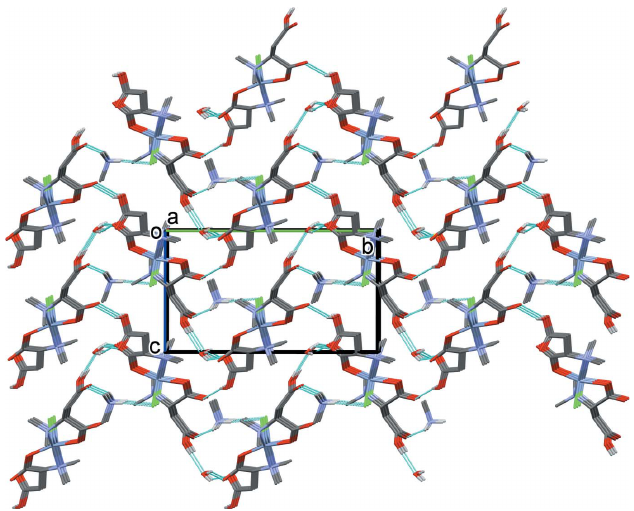
Figure 2 A view along the a axis of the crystal packing of the title complex. The hydrogen bonds (Table 1) are shown as dashed lines and, for clarity, all the C-bound H atoms have been